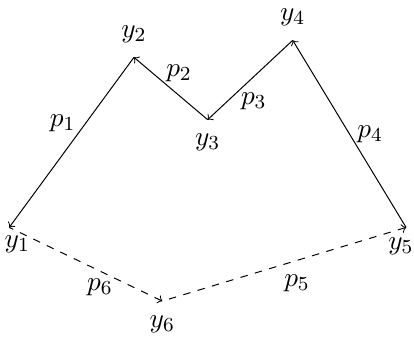
Figure 7 . Momenta and dual coordinates in the case of amplitude with one o(cid:11)-shell and n = 4 on-shell legs. In contrast to the case of o(cid:11)-shell amplitudes, the n on-shell momenta do not add up to zero but to the o(cid:11)-shell gluon momentum k